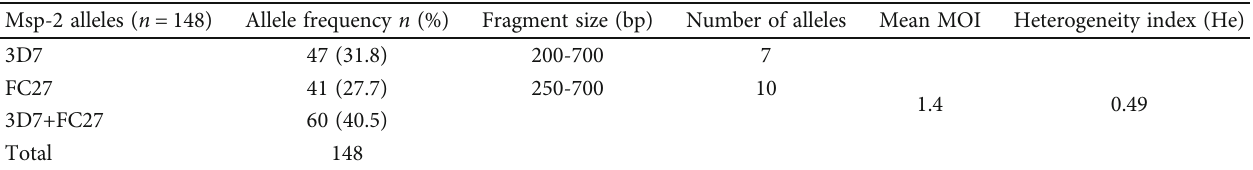
Table 3: Genetic diversity, allelic frequency, and fragment size data of the block 3 region of the msp-2 gene isolated from